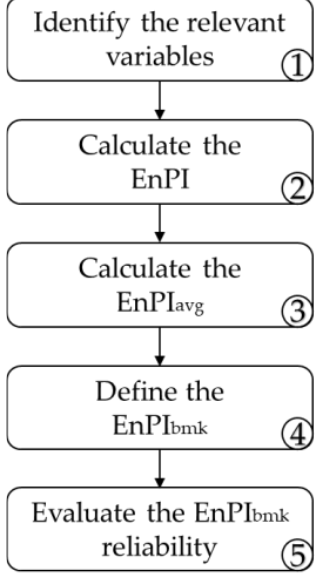
Figure 2. ENEA Figure 2. ENEA methodology.